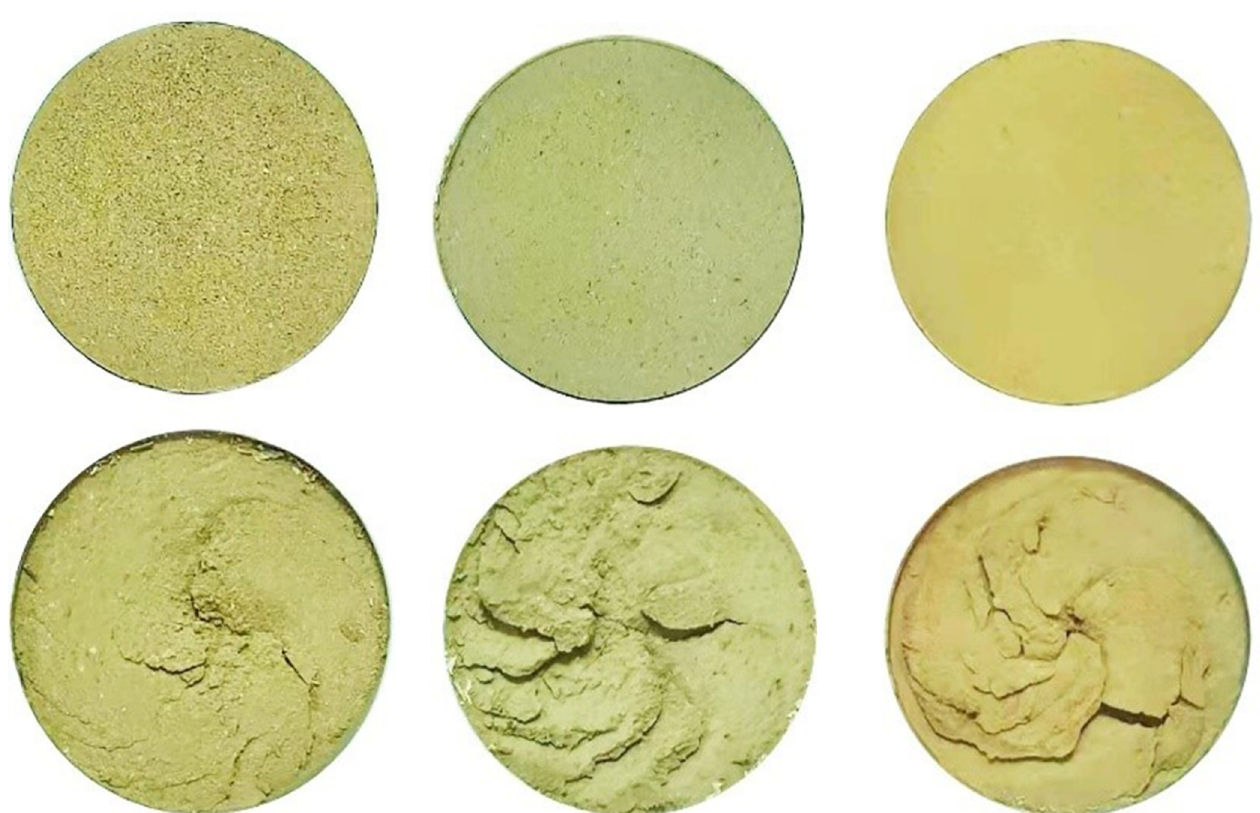
Fig 5. Comparison of the shear surface morphology of 19 # - 21 # remolded loess specimen before and after the test. (A) 19 # v = 0.1 mm / min. (B) 20 # v = 1.0 mm / min. (C) 21 # v = 5.0 mm / min.